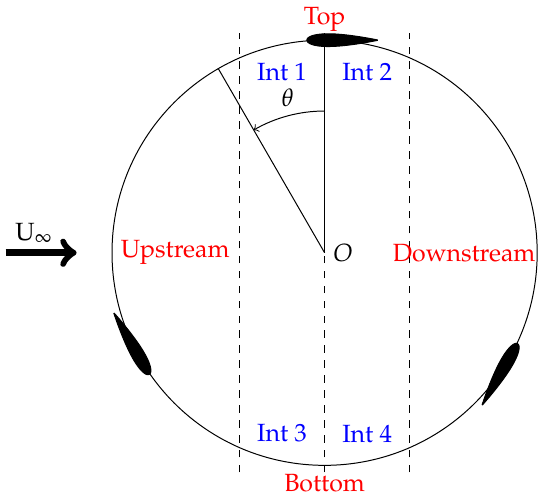
Figure 9. Cutting up of the pitching laws